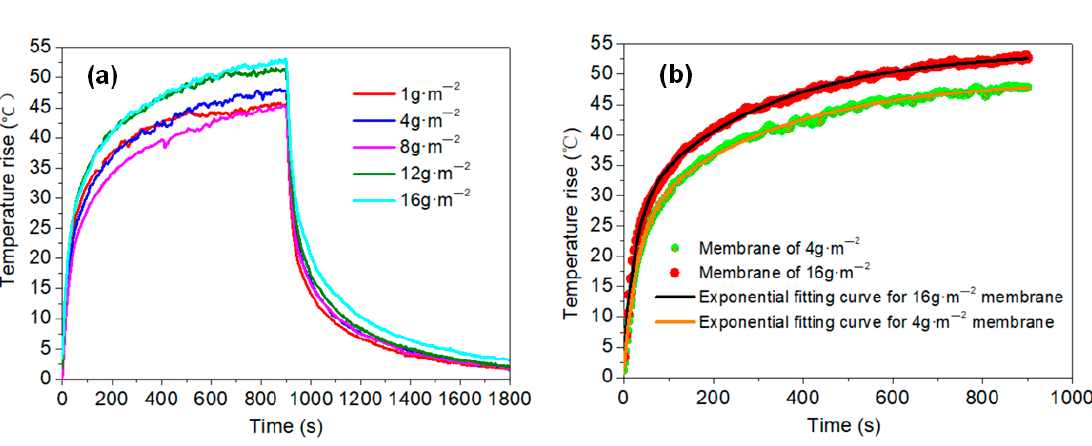
Figure 13. ( a ) Temperature rise of membranes with various grammages; ( b ) Exponential fitting of the 4 and 16 g·m − 2 membranes.